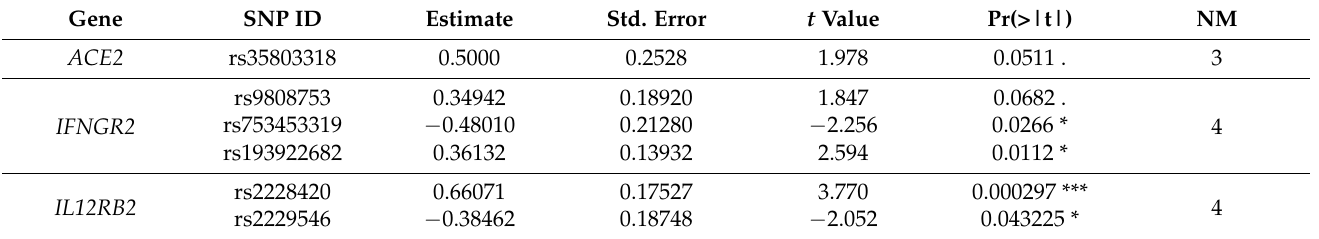
Table 2. Results of multivariate analysis. The table shows the variables (potential predictors) with statistical significance with the occurrence of the illness and the summary of the coefficients found. NM denotes the number of intermediate models used to obtain the final model. Indicated values represent the results obtained for each gene individually within the multivariate